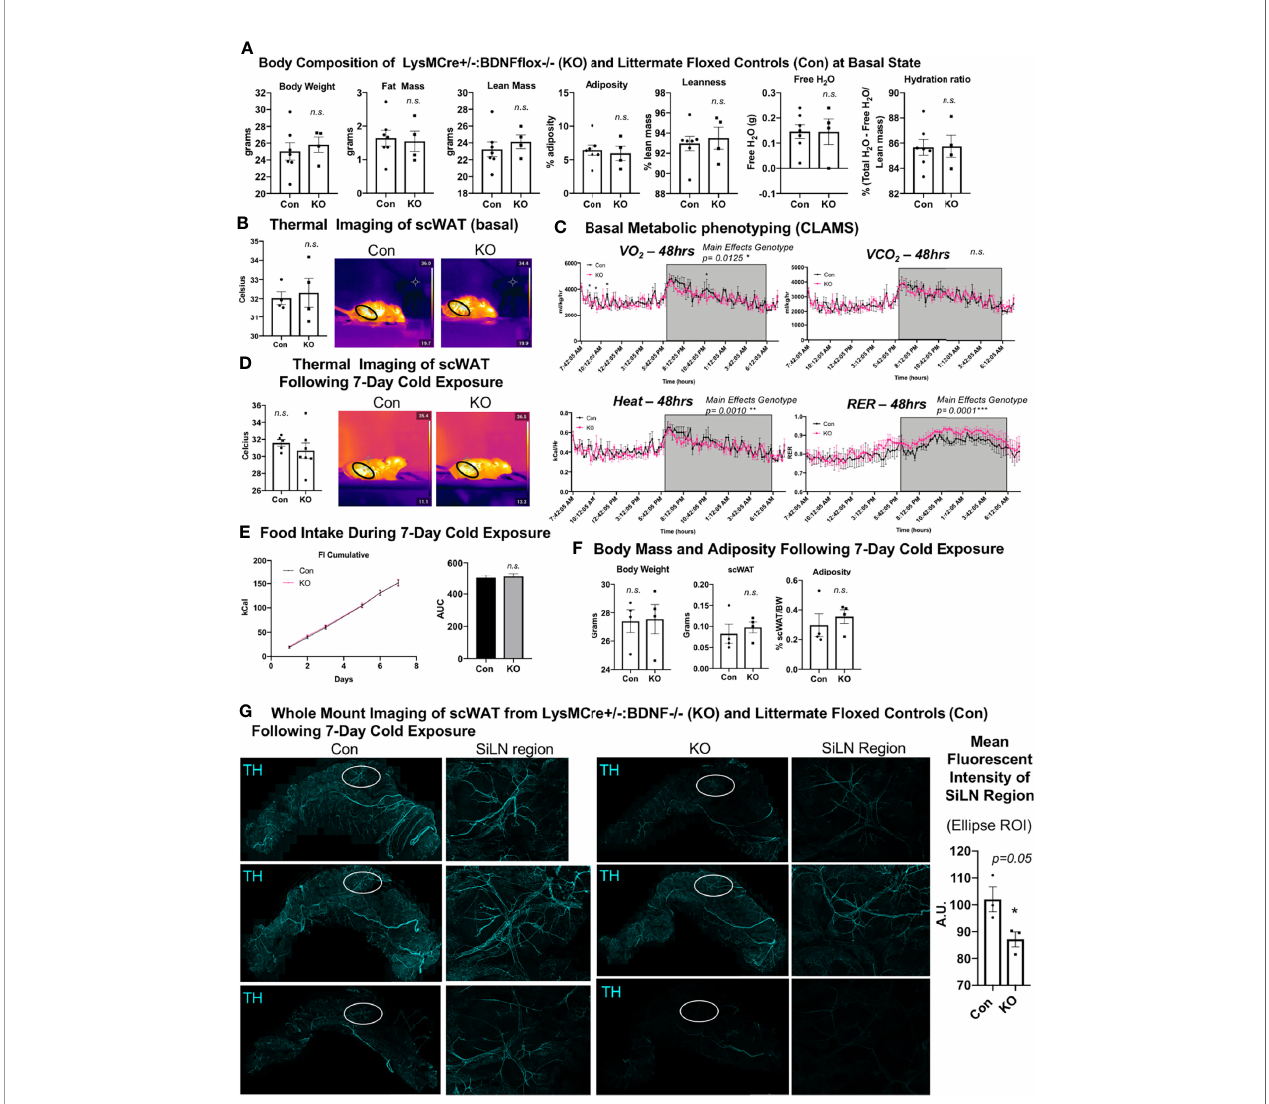
FIGURE 4 | LysMCre +/- ::BDNF -/- (KO) mice showed no difference in body composition, had a lower energy expenditure at the basal state, and exhibited decreased neurite density in scWAT upon cold exposure. (A) The body composition of adult (14 weeks old) male LysMCre +/- :: BDNF -/- (KO) and their littermate LysMCre -/- :: BDNF fl / fl (Con) controls was measured by echoMRI; N = 7 Con, N = 4 KO. (B) The skin surface temperature above the inguinal scWAT of adult (12 – 14 weeks old) Con and KO mice at the basal state was measured using a thermal camera (FLIR T560); N = 4 Con, N = 4 KO. The mean temperature in the region of interest (indicated by the black circle on the thermal images) for n = 3 images per animal was quali fi ed in FLIR Research Studio Application software, plotted in GraphPad Prism software, and analyzed by Student ’ s t -test (two-tailed). (C) Adult (16 weeks old) male Con ( N = 3) and KO ( N = 3) mice were assessed in metabolic cages (CLAMS) at the basal state. The KO mice displayed a lower oxygen consumption (VO 2 , top left panel); decreased energy expenditure is represented as heat calculated from the measures of VO 2 and VCO 2 (bottom left panel), and there was a higher respiratory exchange ratio (bottom right panel) compared with the littermate controls. Waveform analysis of the metabolic cage measurements taken at 15-min increments for 48 h and represented over a 24-h period. Two-way ANOVA was performed, and main effects were reported; p ≤ 0.0001. Time of day is indicated on the x -axis. The animals were maintained on a 12-h light/dark cycle (the gray box indicates the dark cycle). (D – G) Adult (19 – 21 weeks old) Con ( N = 4) and KO ( N = 4) male mice were cold-exposed at 5°C for 7 days. The mice were single-caged in a diurnal incubator (12-h light/dark cycle). (D) The skin surface temperature above the inguinal scWAT of adult (12 – 14 weeks old) Con and KO mice was measured at day 7 of cold exposure and analyzed as described in (B) . (E) Food intake was measured nearly daily throughout the cold exposure intervention. The area under the curve for cumulative food intake was calculated and compared for Con and KO animals. (F) The body mass and tissue weights were measured, and adiposity was calculated. Data were analyzed by Student ’ s t -test (two-tailed). (G) Whole-mount immunostaining and imaging were performed on scWAT from cold-exposed Con and KO male mice. The tissue was stained with tyrosine hydroxylase for the assessment of sympathetic innervation. Imaging was performed on a confocal microscope equipped with WLL using an objective at ×10 magni fi cation. The images are z-maximum intensity projections (with median blur fi lter and 4 kernel size applied) of merged tiled z-stack imaging of the entire scWAT depot. White circles represent the SiLN region (inset to the right of each image) for which the mean intensity was quanti fi ed (far right). All error bars are SEMs. *p-value < 0.05; n. s., not signi fi